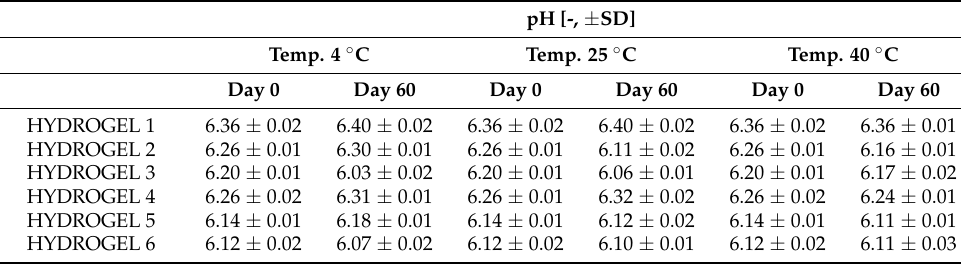
Table 3. Changes in pH of the hydrogel formulations stored under various temperature conditions (4, 25, 40 ◦ C) for 60